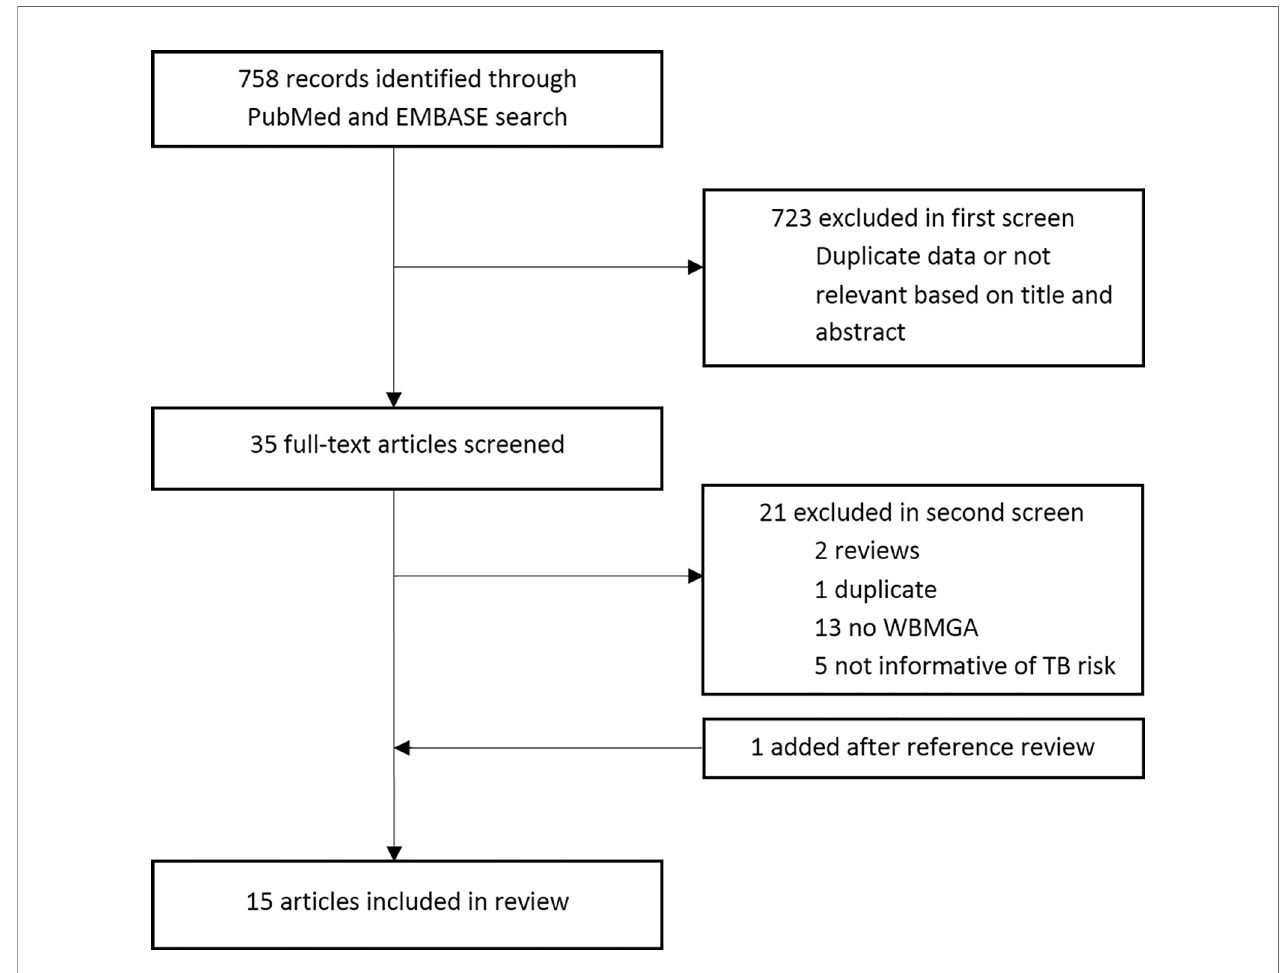
FIGURE 1 | Flow chart of paper